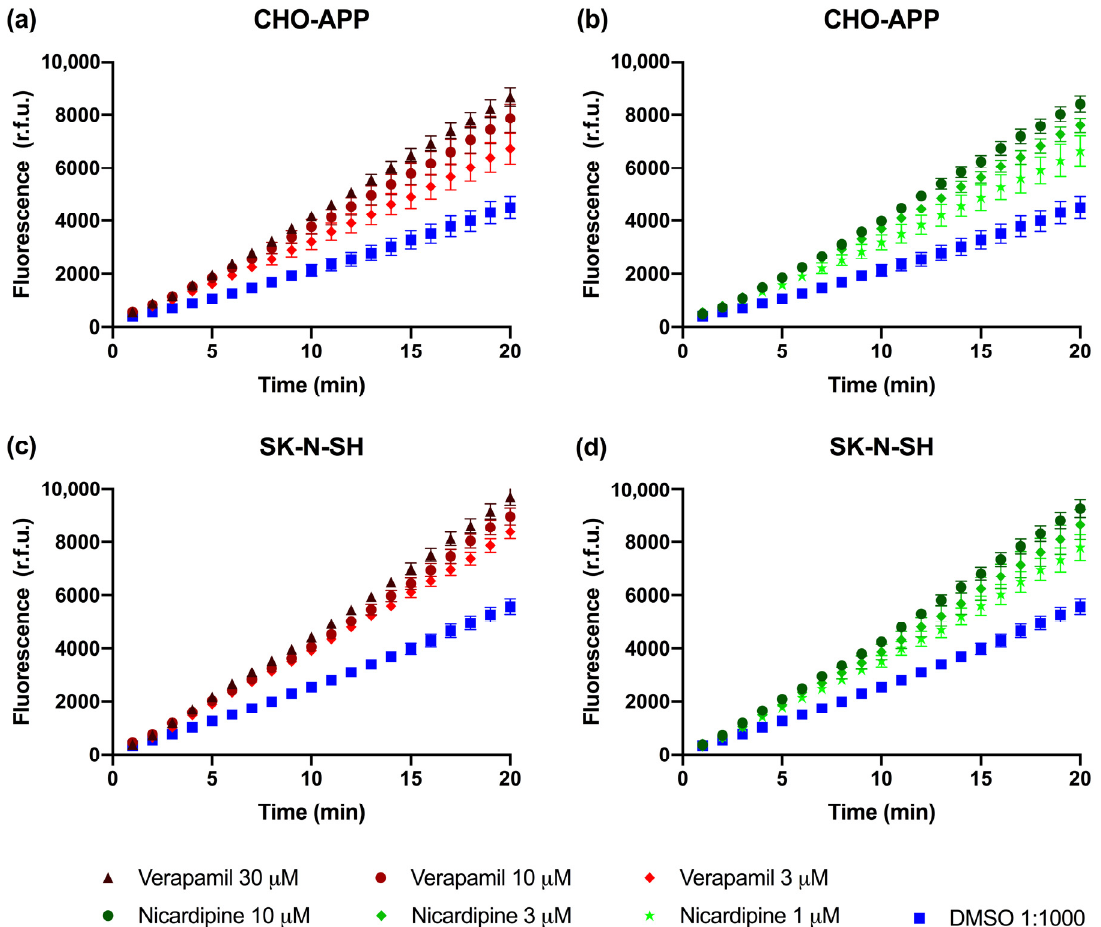
Figure 4. P-gp activity in CHO-APP and SK-N-SH cells. P-gp efflux activity was measured using the fluorogenic P-gp substrate calcein-AM. CHO-APP cells were treated with ( a ) verapamil at 3, 10 or 30 µ M or DMSO control, or ( b ) nicardipine at 1, 3, or 10 μ M or DMSO control, immediately prior to the addition of 0.1 μ M calcein-AM. Similarly, SK-N-SH cells were treated with varying concentrations of either ( c ) verapamil or ( d ) nicardipine or DMSO control. Fluorescence measurements were obtained at 485/535 nm every minute over twenty minutes. Data are presented as the mean ± SEM of three independent experiments, with each condition conducted with six replicates.